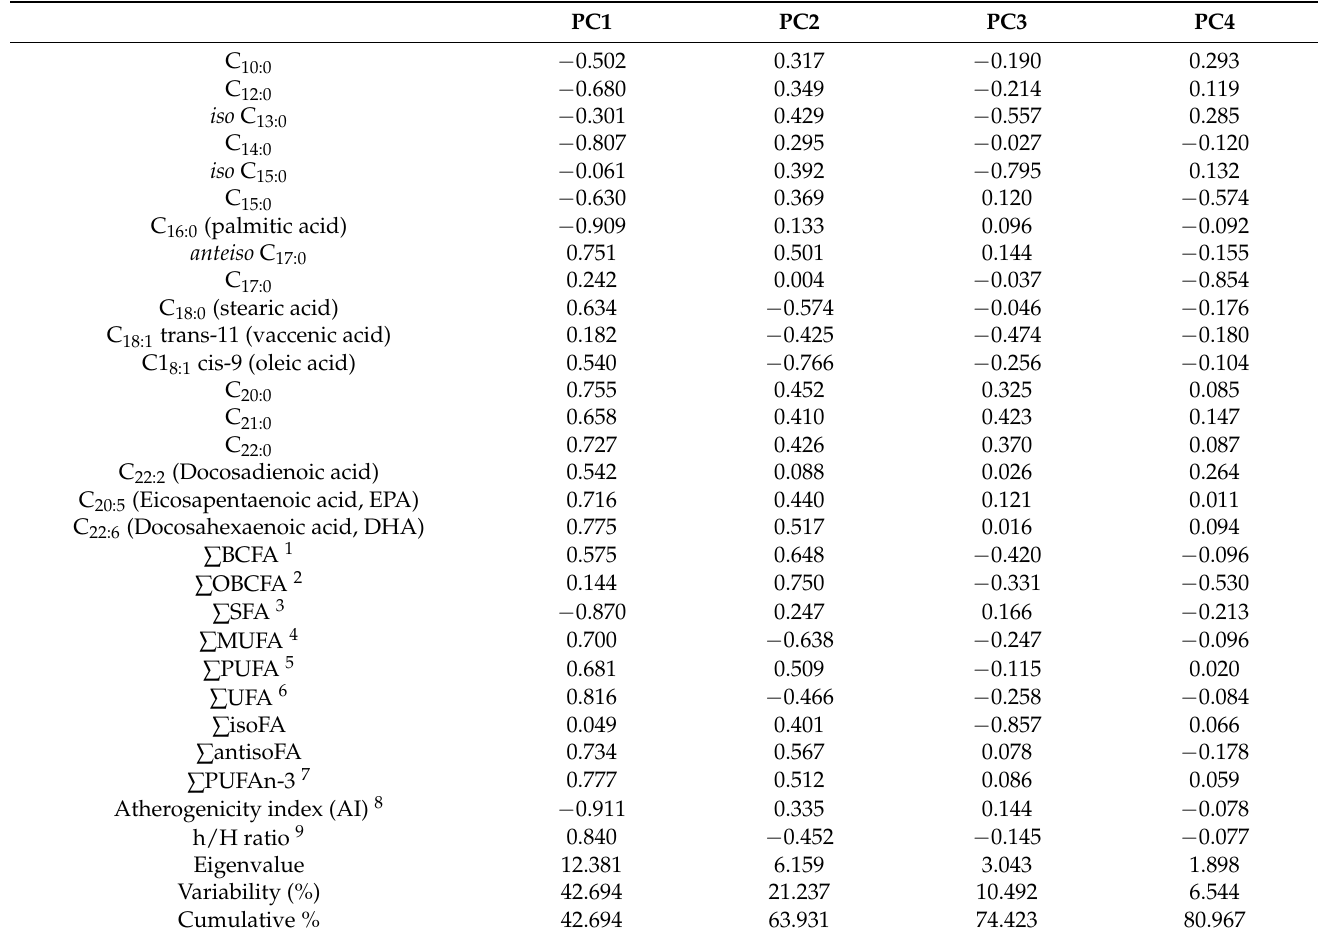
Table 5. Eigen analysis and correlations between variables and